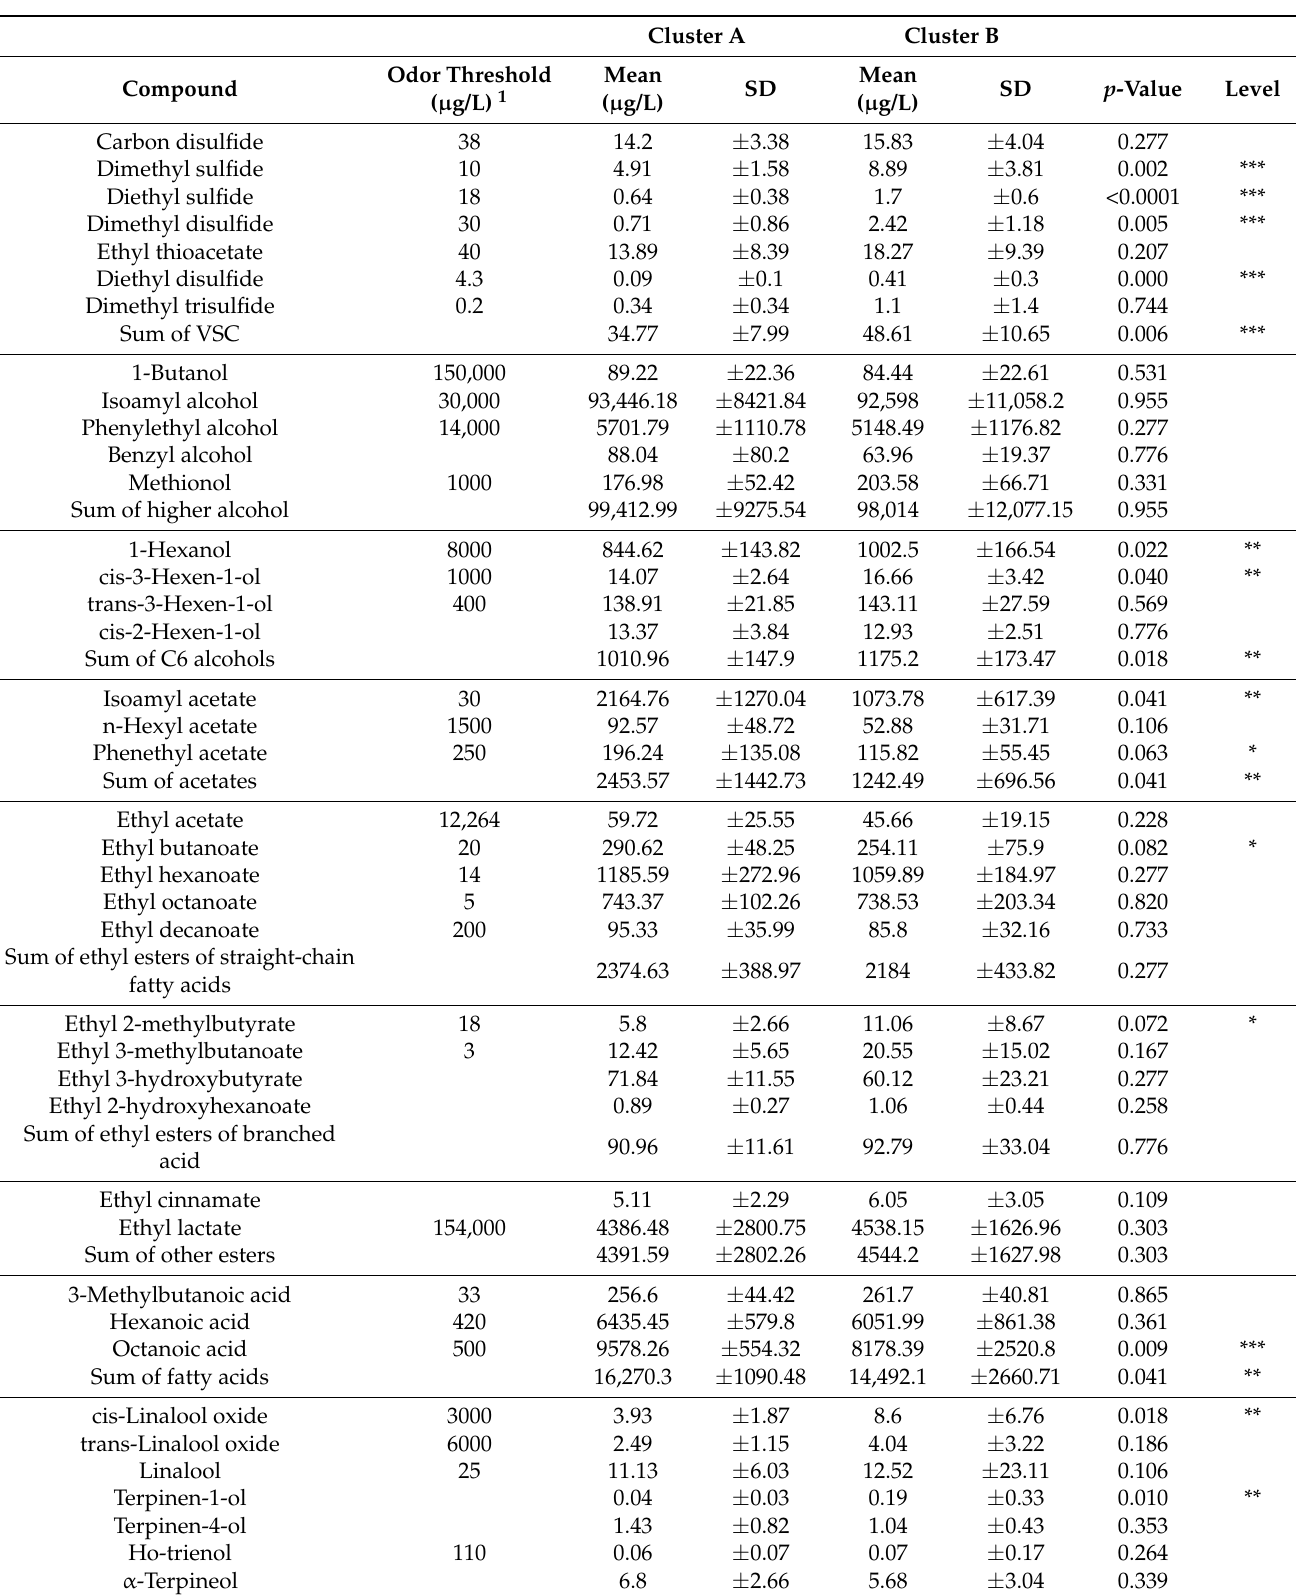
Table 5. Concentration ( µ g/L) of free volatile compounds in cluster 1 and cluster 2 wine sam- ples. Odor threshold, mean, standard deviation (SD), statistical significance ( p -value), and level